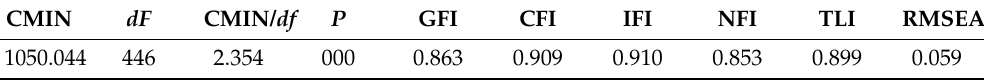
Table 5. Summary of the goodness-of-fit indices of the measurement model of this study.